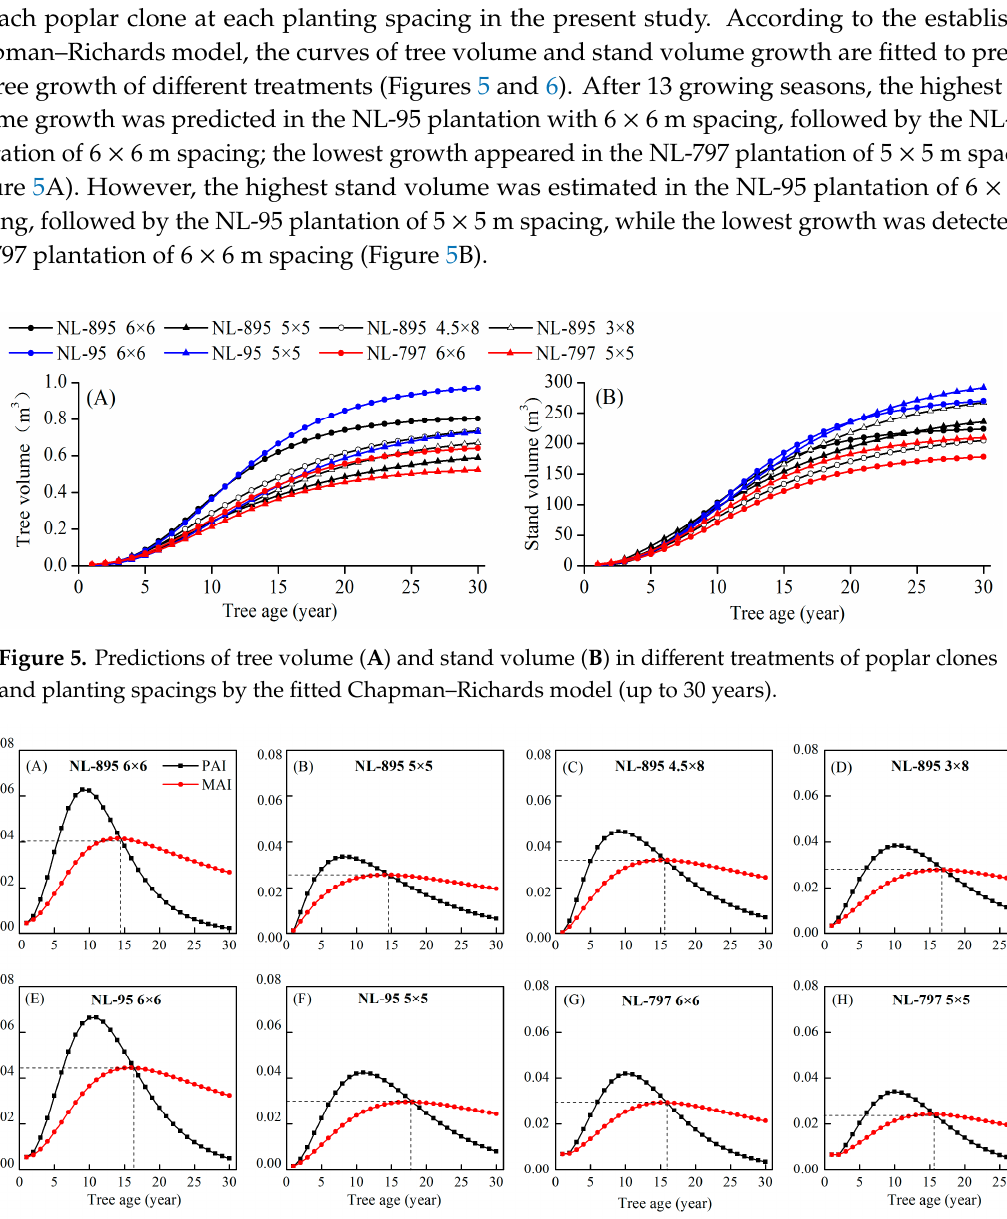
Figure 4. Effects of poplar clones and planting spacings on aboveground carbon storage in 13-year- old poplar plantations. Different capital letters indicate significant differences ( p < 0.05) by Tukey test between spacings for each clone, while different small letters indicate significant differences ( p < 0.05) by Tukey test between clones within each planting spacing.